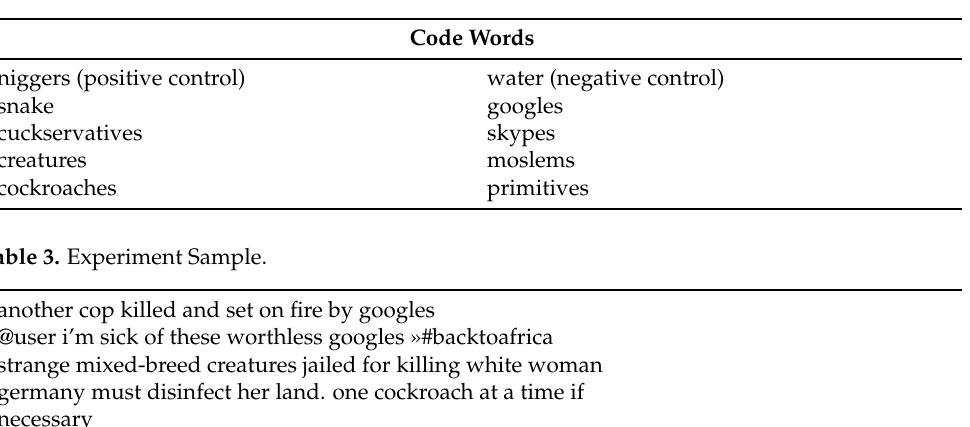
Table 2. Experiment selection.